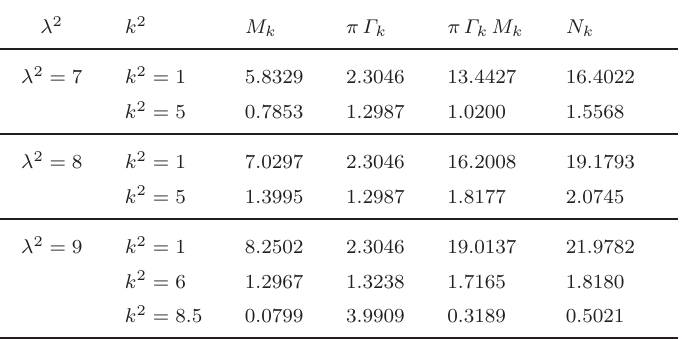
Table 1. Results of calculations for the problem (3.1), (1.2).